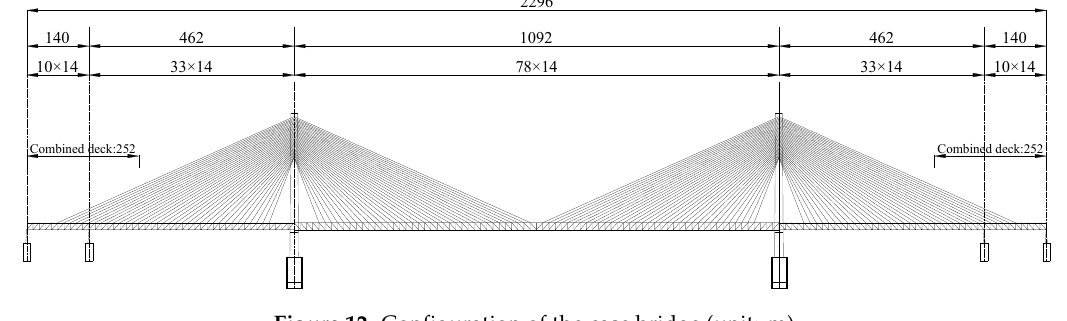
Figure 12. Configuration of the case bridge (unit: m).